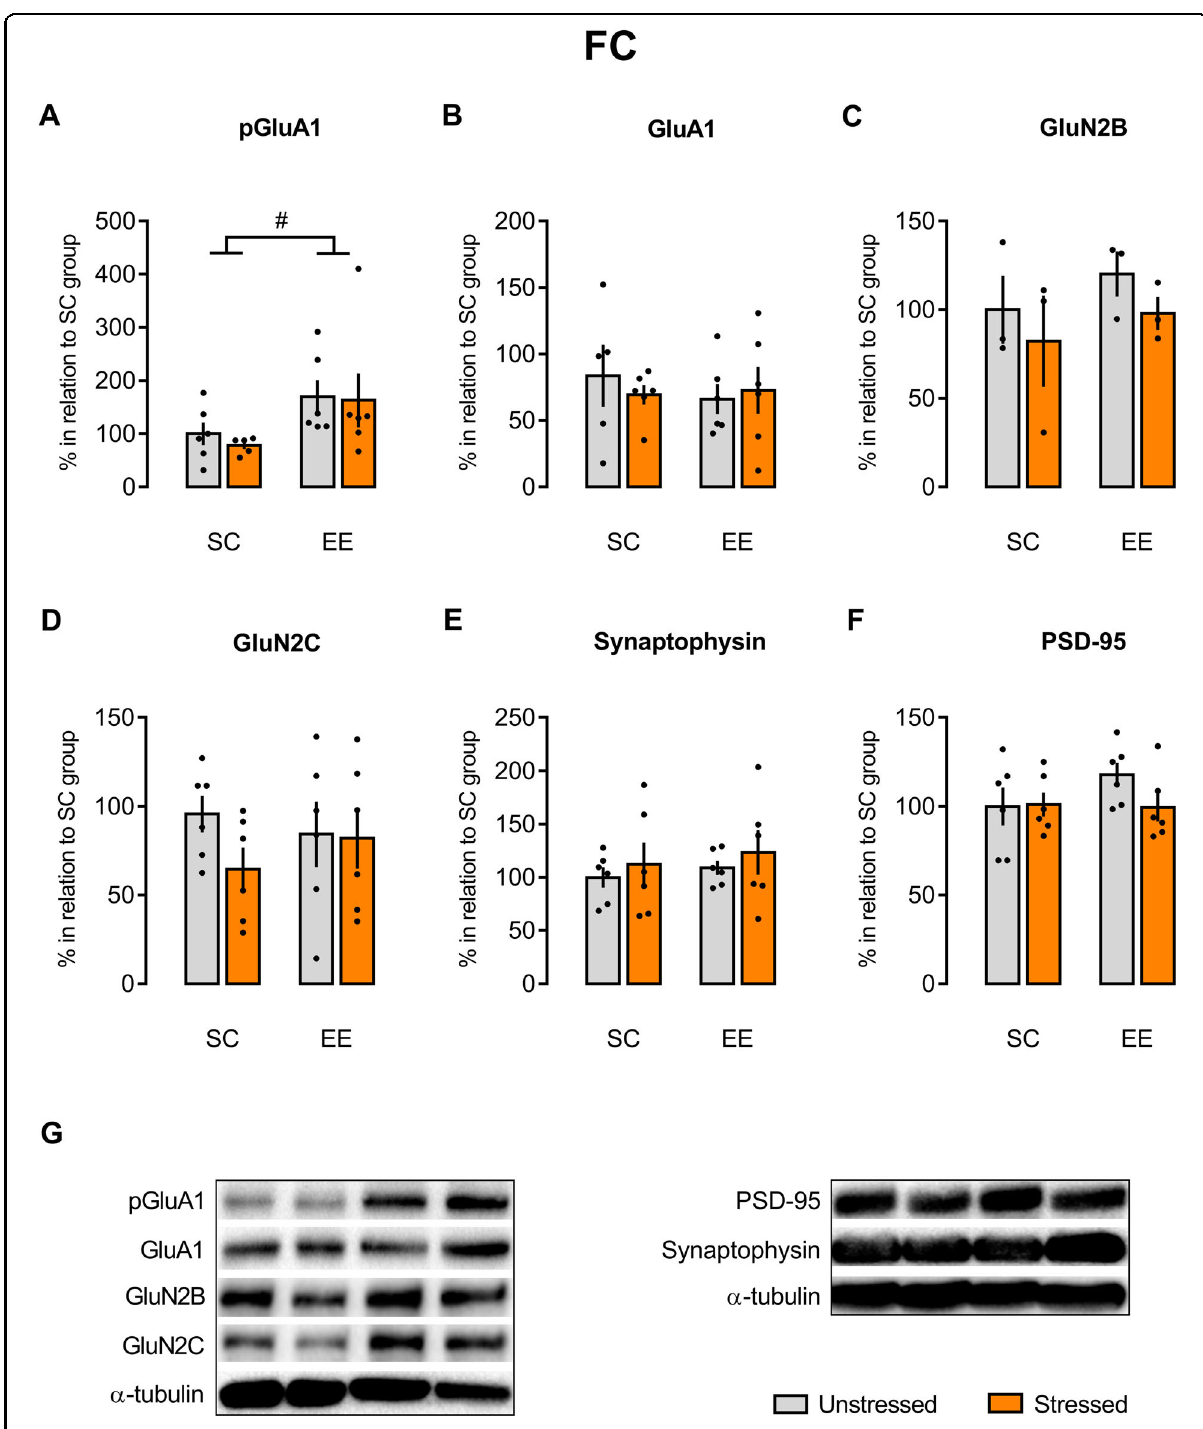
Fig. 5 There is no stress effect on the GluA1 phosphorylation in the FC, but there is an EE effect. There was an environmental effect on the pGluA1 ( A ) expression in the FC, but there were no effects of either environment or stress on the expression of GluA1 ( B ), GluN2B ( C ), GluN2C ( D ), synaptophysin ( E ), and PSD-95 ( F ) in the same brain area. Representative autoradiography of western blot ( G ). Results are represented as mean ± SEM ( n = 5 – 6 animals per group in A and B ; n = 6 for each group in D – F ; n = 3 for each group in C ). Two-way ANOVA followed by Tukey ’ s multiple comparisons test (no differences were detected between the experimental groups). ANOVA signi fi cant main effect is indicated as # p <